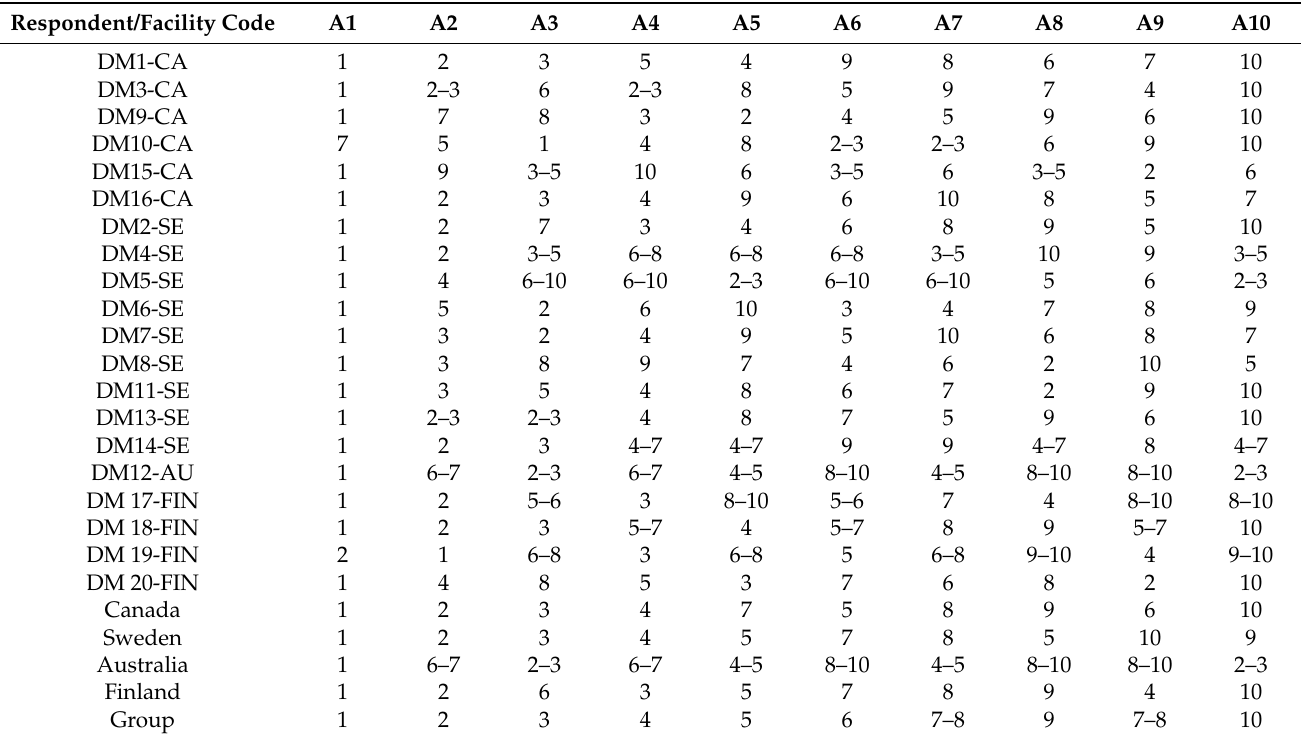
Table A3. Ranking of attributes, by respondent, country, and group. For definitions of the attributes, see Table 1.